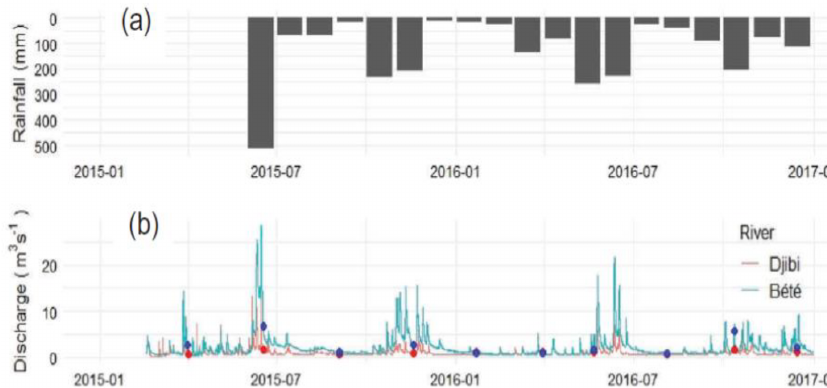
Figure 2. Rainfall (a) and Discharge (b) relationship in Aghien lagoon watershed (Ehouman et al., 2019).